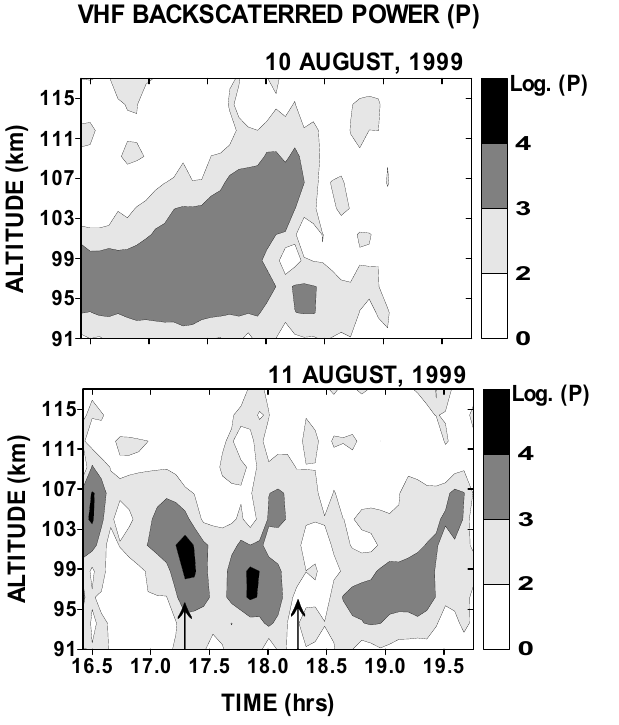
Fig. 4. A comparison of RTI plots of the backscatter returns over the height region of 91–115km in the electrojet on 10 August (top panel) and on 11 August (bottom panel) during 16:30–20:00IST. The duration of the eclipse is indicated by the arrow marks.